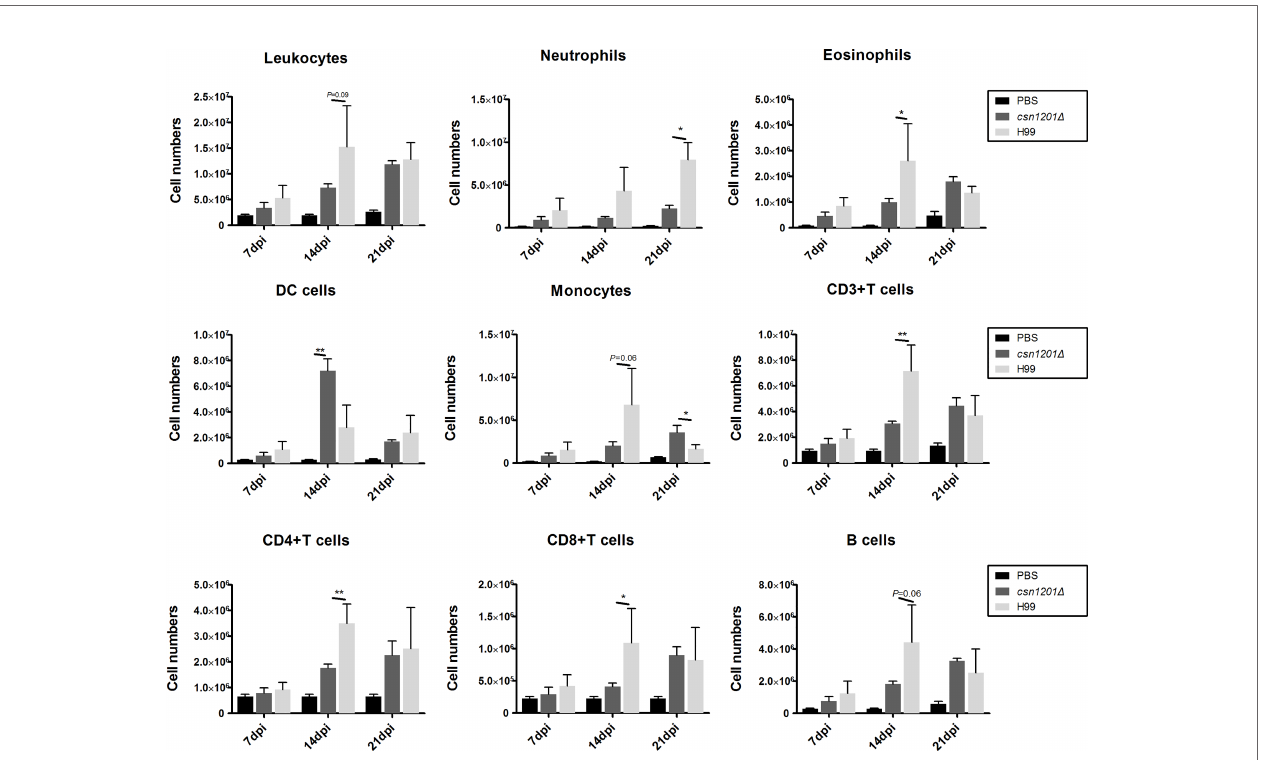
FIGURE 8 | The CSN1201 deletion alters the pulmonary in fl ammatory recruitment pattern during cryptococcal infection. Subsets of pulmonary immune cells from mice infected with C. neoformans were assessed by fl ow cytometry. Values are the mean ± SEM, n = 4 or more mice per group. *, P < 0.05; **, P <